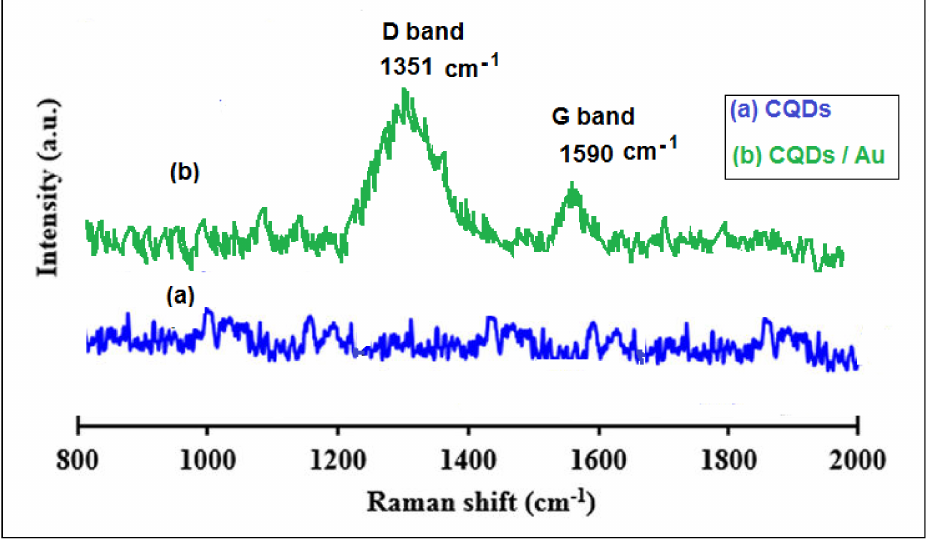
Figure 6. Raman spectra shift of ( a ) CQDs and ( b ) the CQDs/Au